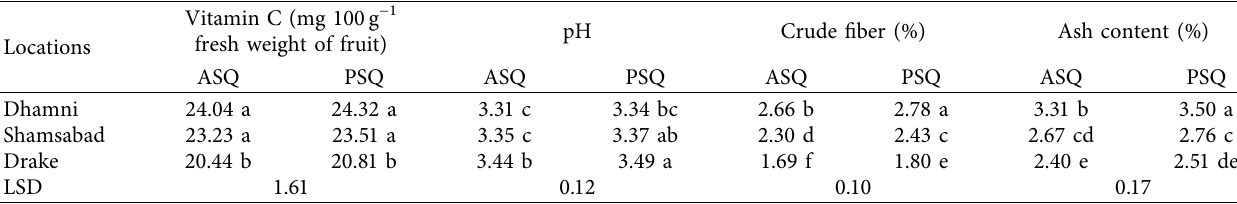
Table 2: Vitamin C, pH, crude fiber, and ash content of two quince ecotypes from three different locations of Rawalakot, Azad Jammu and